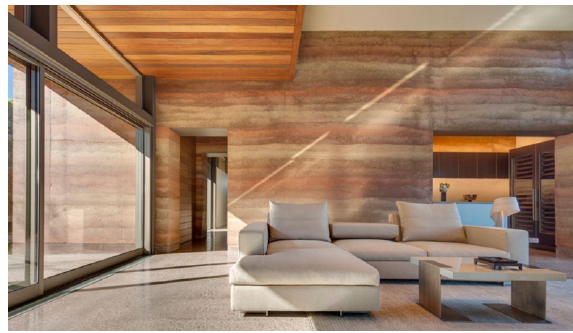
Figure 2. The family house in New Mexico